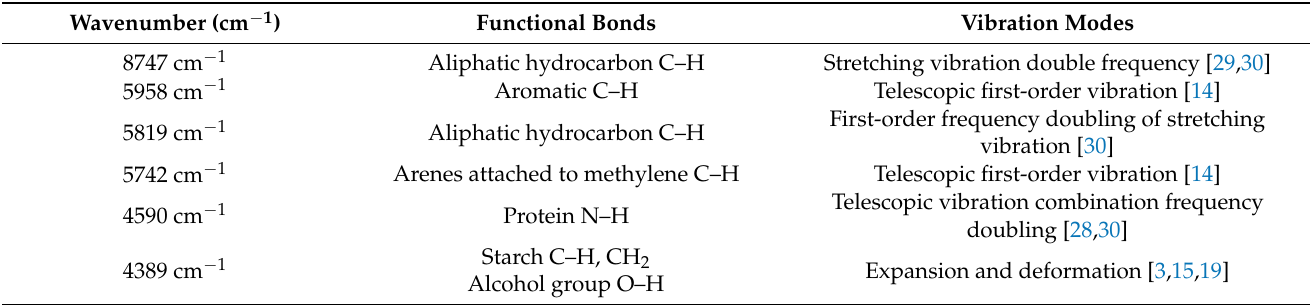
Table 2. Functional bonds and vibration modes in the NIRT